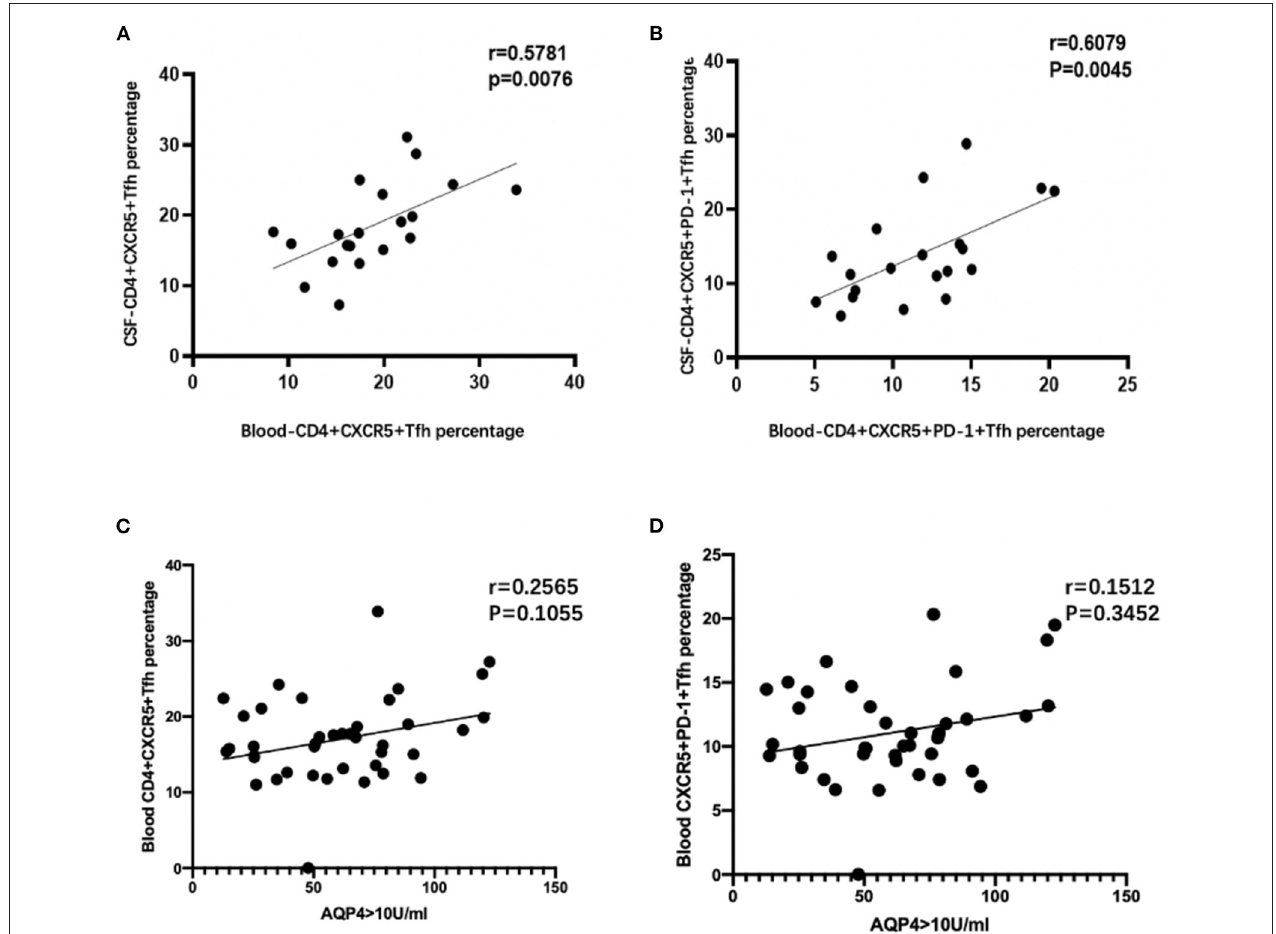
FIGURE 3 | (A,B) Correlation analysis between CSF and blood Tfh cell percentages in CD4 + T cells of all patients with both blood and CSF samples. (C,D) Correlation analysis between blood Tfh cell percentages in CD4 + T cells and AQP4 value of NMOSD